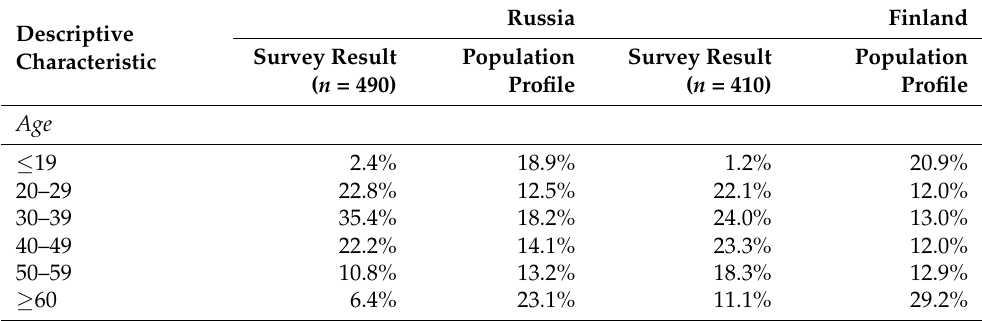
Table 1. Descriptive statistical analysis of obtained